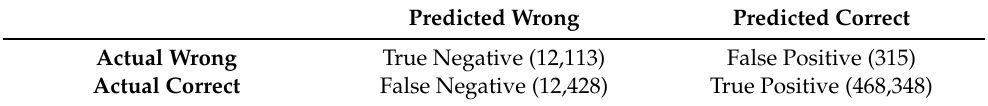
Table 6. Validation confusion matrix (UPTI).